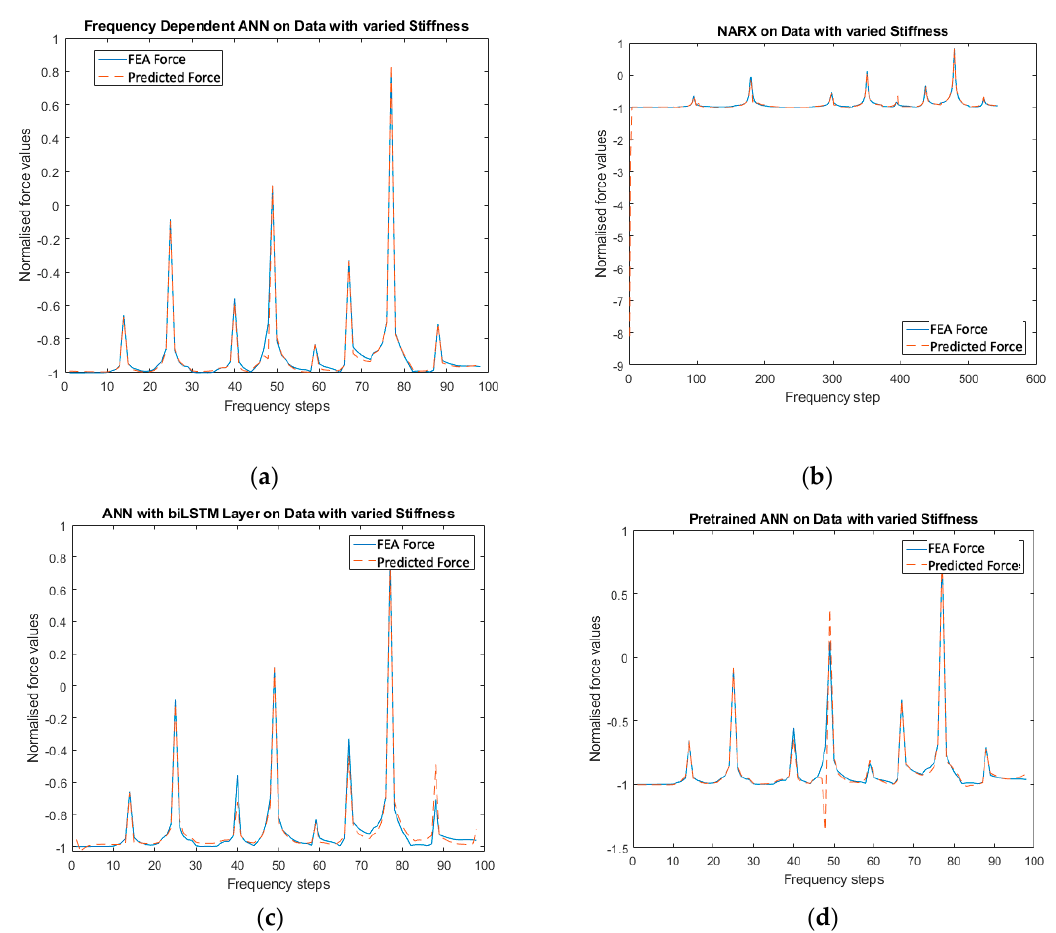
Figure 7. Actual and predicted element force over frequency steps for the academic case with 68 sensors: ( a ) frequency-dependent ANN, ( b ) NARX with more frequency steps, ( c ) ANN with bidirectional long short-term memory layer (biLSTM) layer, and ( d ) pretrained ANN.